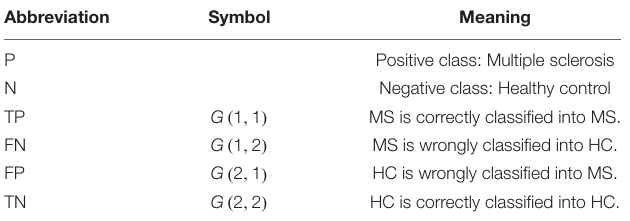
TABLE 3 | Definitions in the confusion matrix. TABLE 4 | Parameter